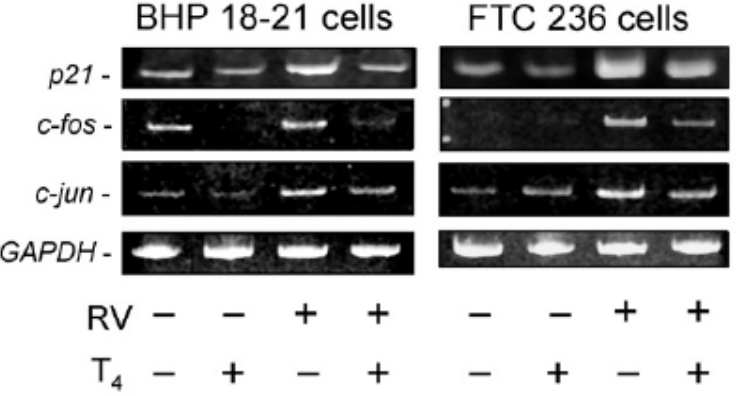
Figure 3. Effects of T4 on mRNA abundance (RT-PCR) of pro-apoptotic p21 , c-fos , and c-jun in human differentiated papillary (BHP 18-2) and follicular (FTC 236) thyroid carcinoma cells. Cells were treated in vitro for 24 h with resveratrol (RV) (10 µM) or T4 (10 -7 M total hormone concentration, 10 -10 M free hormone) or with both agents. T4 inhibited the expression of RV-induced pro-apoptotic genes and did not affect control GAPDH gene. GAPDH , glyceraldehyde 3-phosphate dehydrogenase. Reprinted with permission from Elsevier from Lin et al. [16].